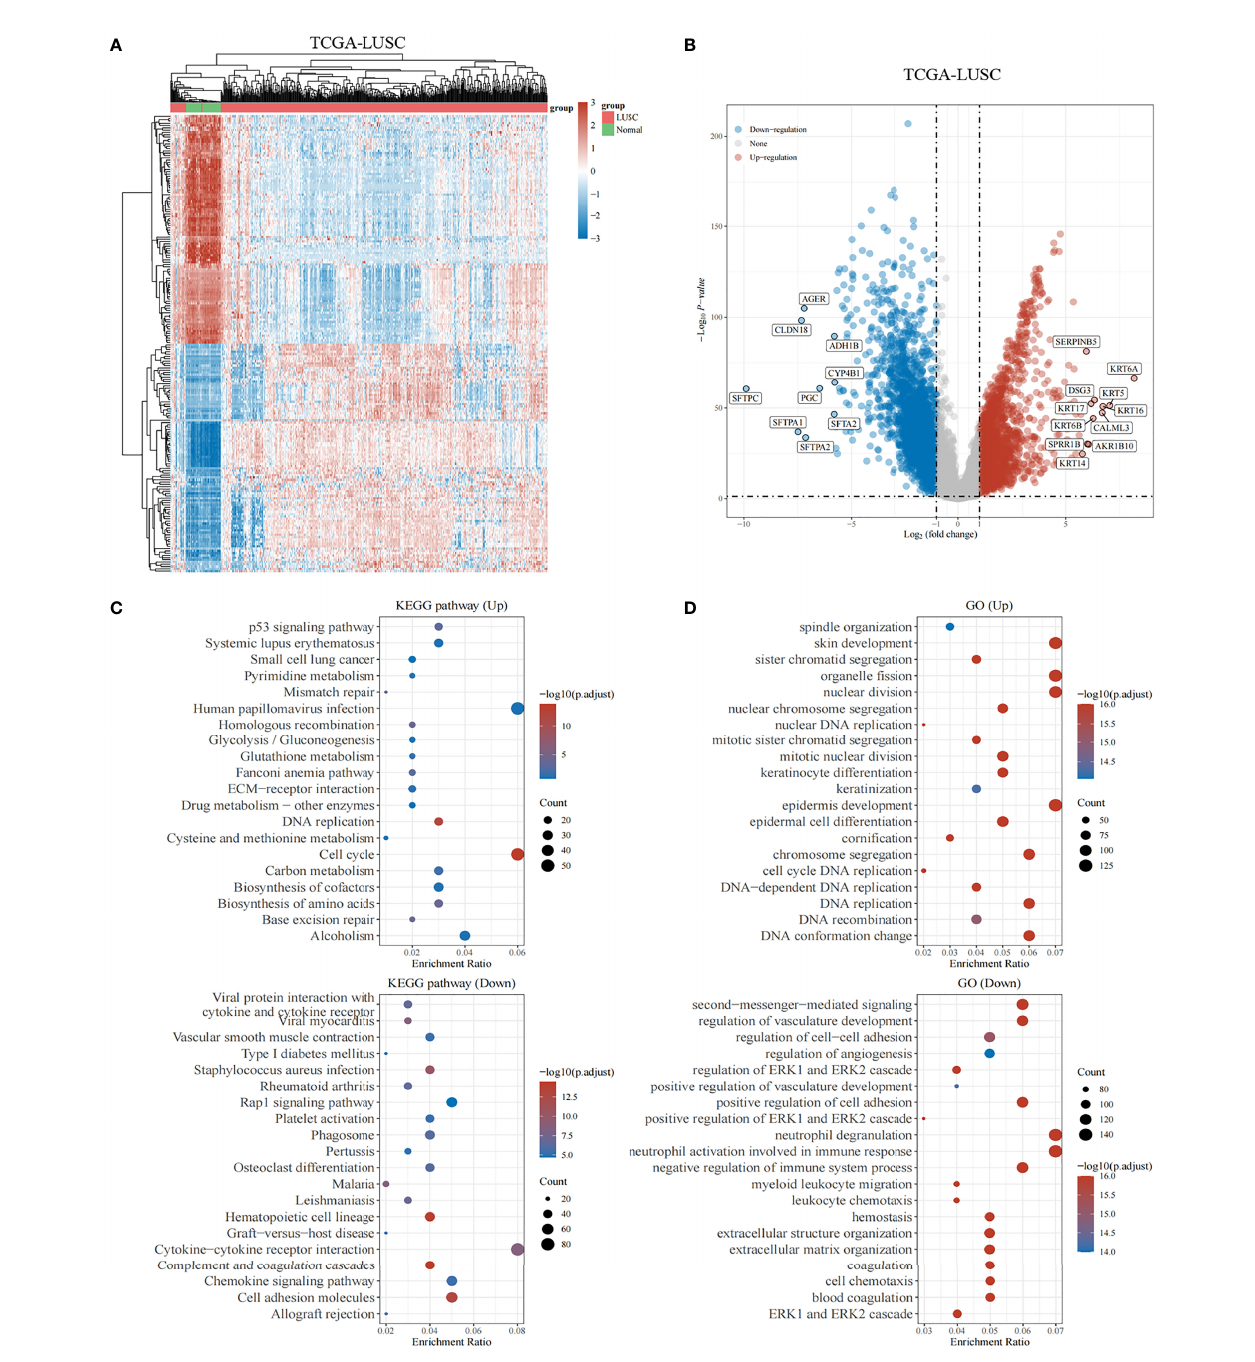
FIGURE 2 | Genes differentially expressed in lung squamous cell carcinoma. (A, B) The heatmap and volcano plot shows differentially expressed genes in lung squamous cell carcinomas based on the TCGA database. Up- and downregulated genes are indicated in red and blue, respectively. (C) Bubble graph for KEGG pathways. (D) Bubble graph for GO in Figures 7C – F ). The relationship was not noteworthy among people with late T stage disease. According to the TNM stage, no Figure 7B ). When strati fi ed by sex and N stage, the risk score association between risk scores and survival was observed in LUSC patients with advanced stage, but high-risk patients with was signi fi cantly associated with survival in both groups (shown